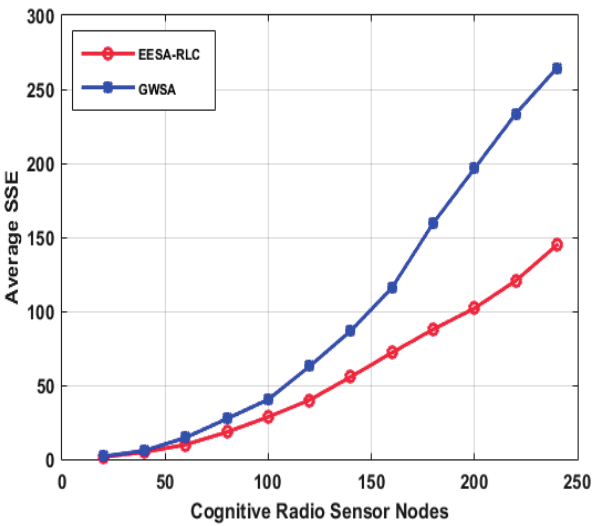
Figure 12. Average SSE for CRSN